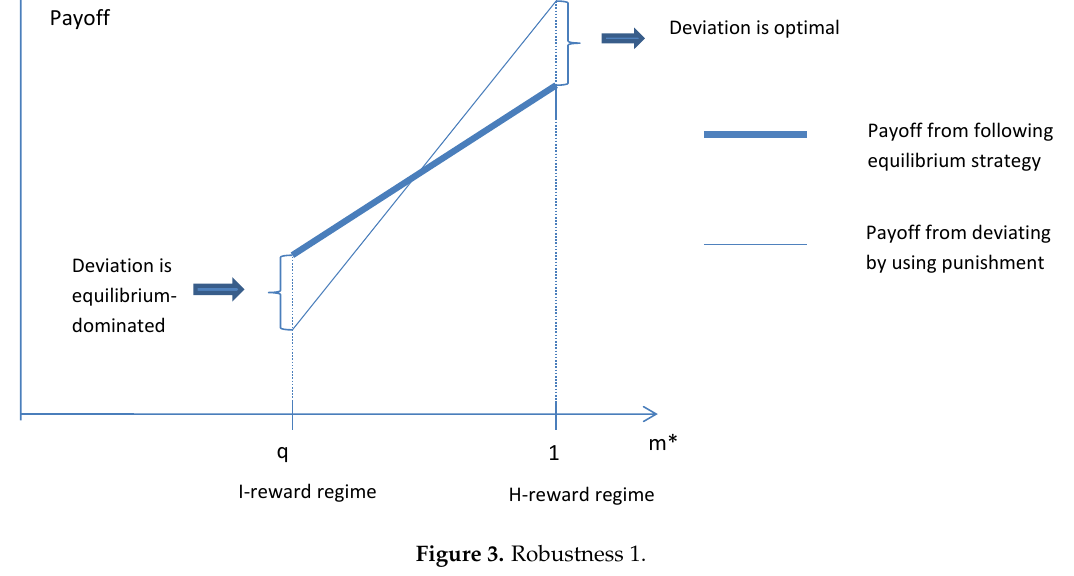
Figure 3. Robustness